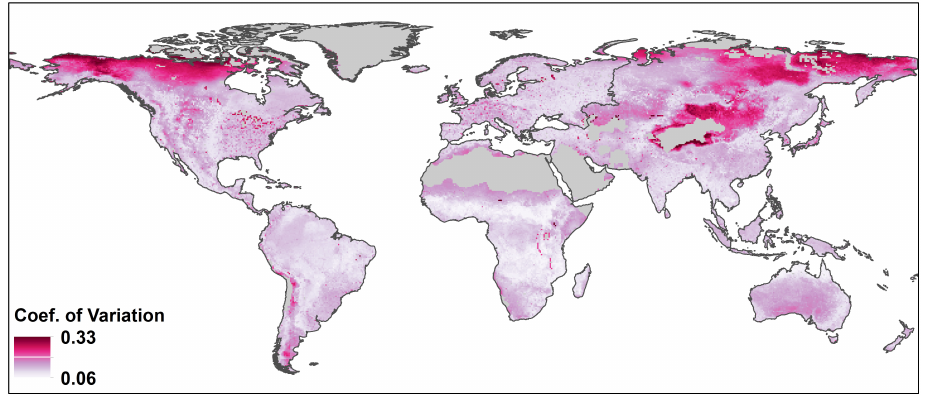
Figure 5. Map of the average coefficient (Coef.) of variation derived from modified indices. Higher values (dark purple) show higher sensitivity to the weighting scheme used.